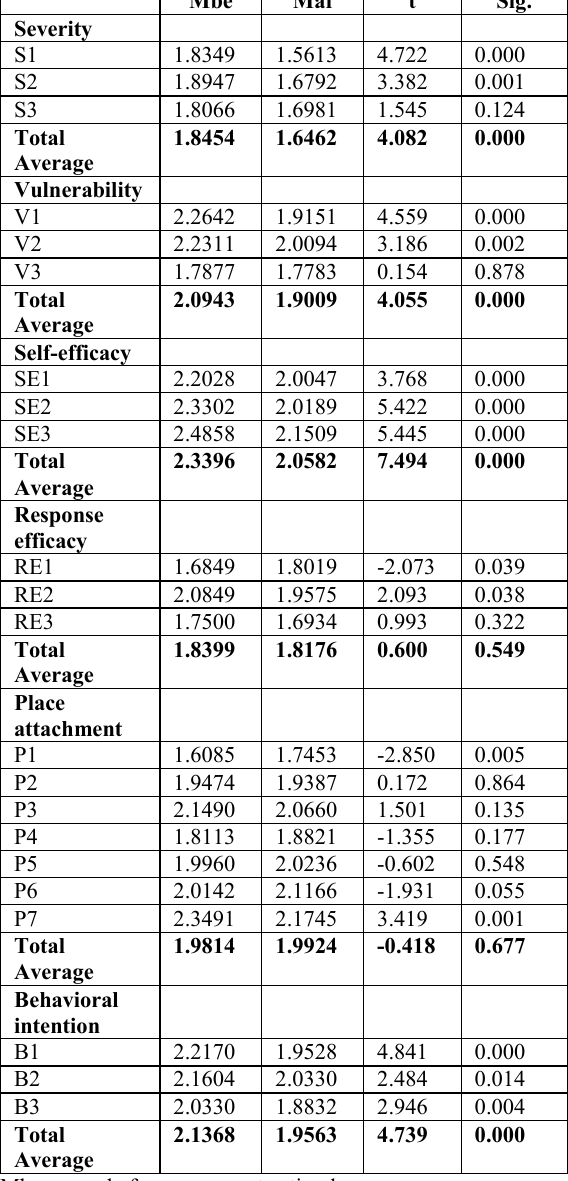
Table 1. Mean differences paired t-test